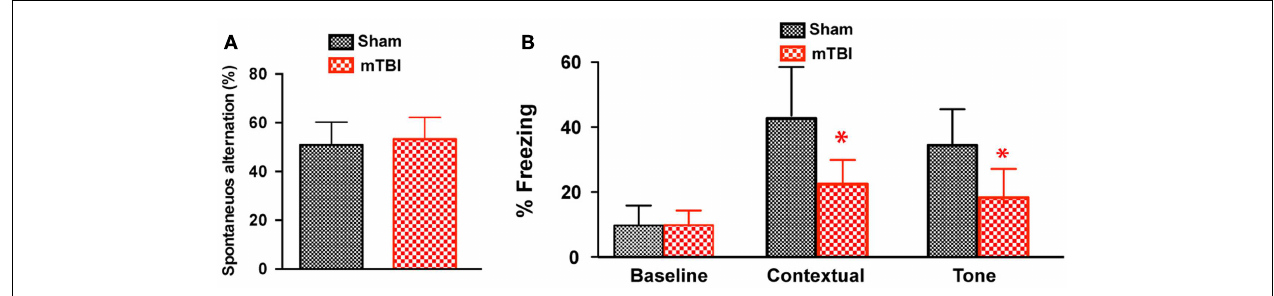
spontaneous alternations between mTBI and sham mice. (B) In the fear conditioning test, no significant statistical difference was apparent in baseline freezing, however, mTBI mice showed significantly impaired context and cued memory compared with sham animals.